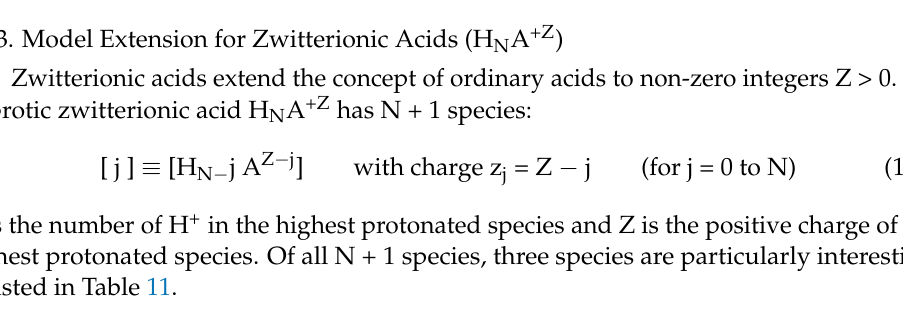
Table 11. Three exceptional cases out of N + 1 acid